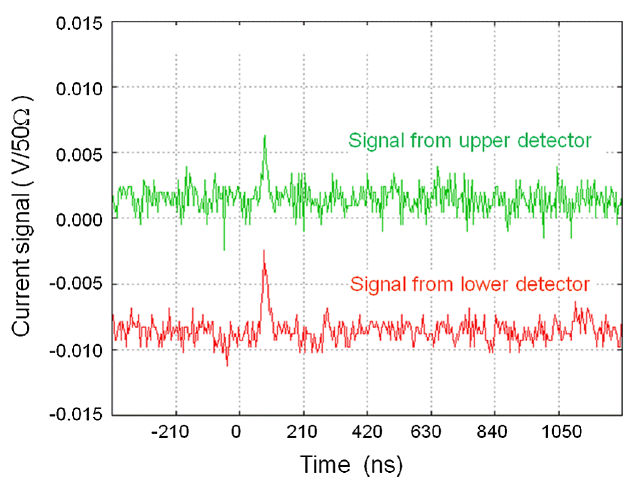
FIG. 19. Typical waveform stored in database. The upper (green) waveform is from the upper detector and the lower (red) waveform is from the lower detector.